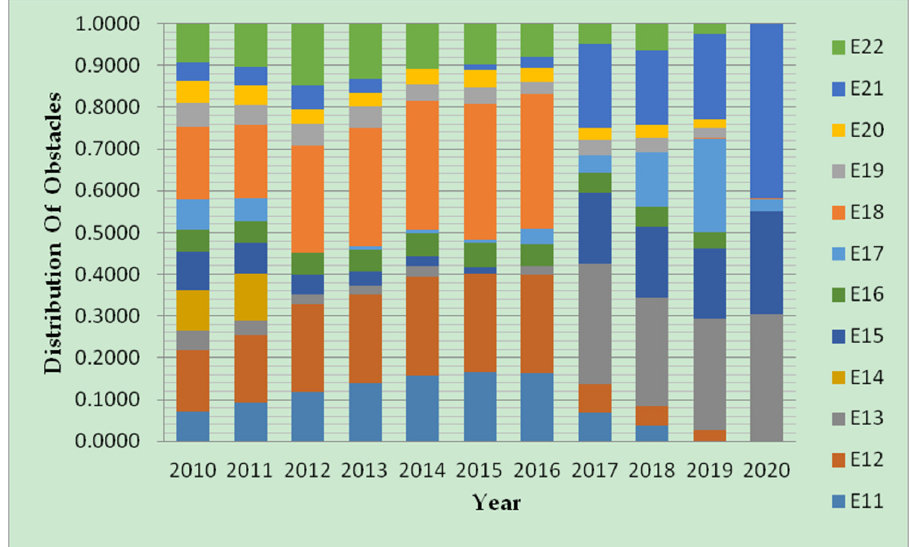
Figure 6. Distribution of obstacles to improving cultivated land-use benefits in Xiangyang